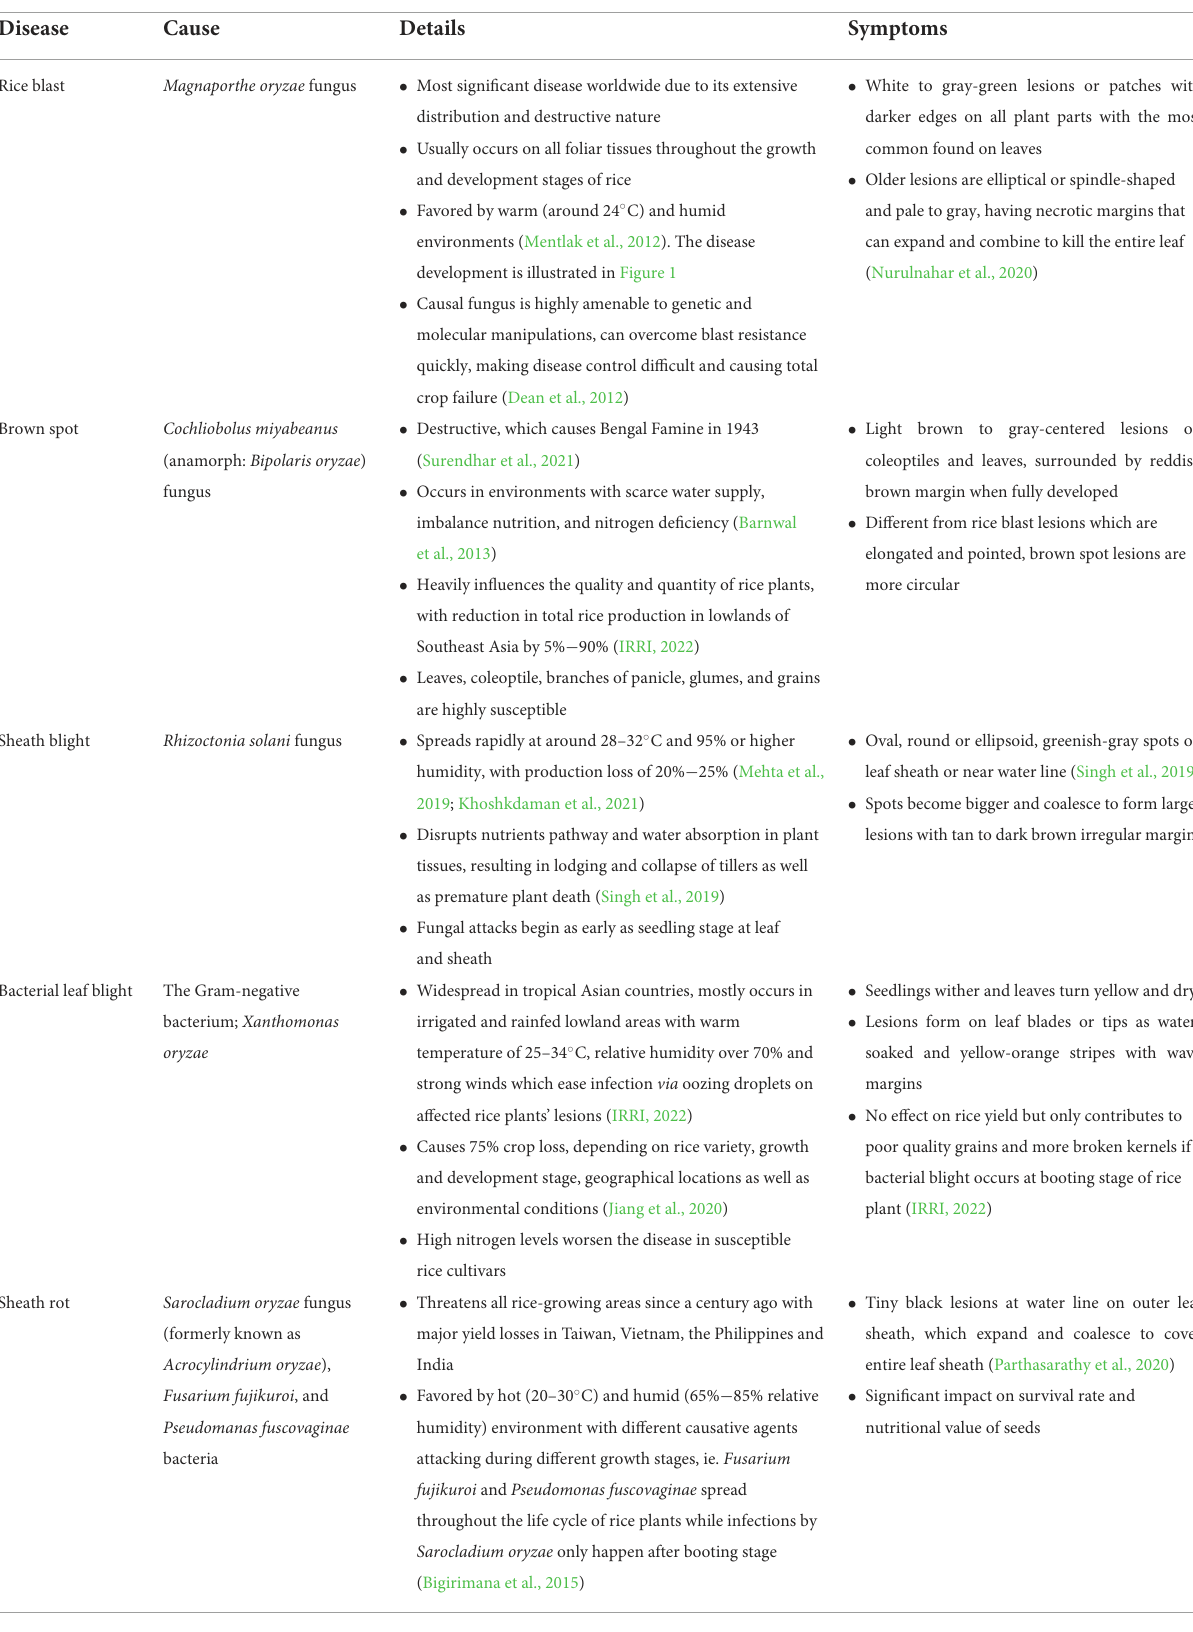
TABLE 1 A summary of major diseases affecting rice